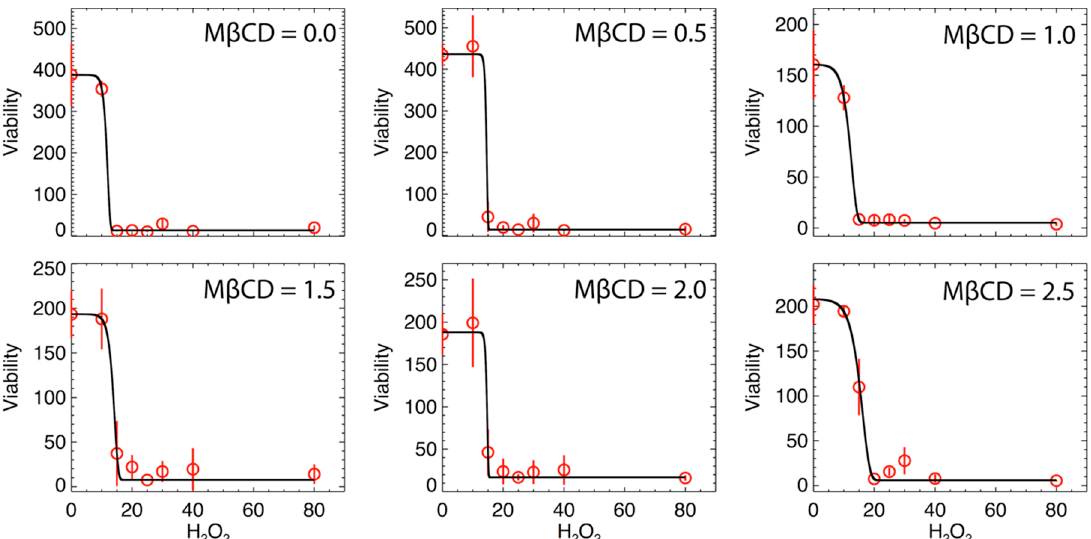
Figure 8. (Left) Diagrams of the modified p -value and reduced chi-square characterizing the linear fitting of the parameters α (a) , β (b) , γ (c) , and δ (d) , with MßCD plotted, as a function of the multiplication factor (M.F.). We identify the M.F. value, for which the corresponding p -value and reduced chi-square are optimized. The goodness of fit is shown using both the modified p -value and reduced chi-square. (Right) Here, the goodness of fit is shown using the unified measure as given by Equation (9) while it is depicted as a function of the signal-to-noise ratio of the slope b/ δ b , characterizing the linear fitting of the parameters with MßCD; (note: Both the ratio b/ δ b and the goodness of fitting are plotted as functions of the multiplication factor (M.F.)). The cases of the parameter α and γ have the optimal values of the p -value and reduced chi-square for │ b/ δ b │ < 1, so that the hypothesis of being dependent on MßCD is rejected. On the other hand, the cases of the parameter β and δ have the optimal values of the p -value and reduced chi-square for │ b/ δ b │ >> 1, thus, the hypothesis of MßCD dependence is accepted.